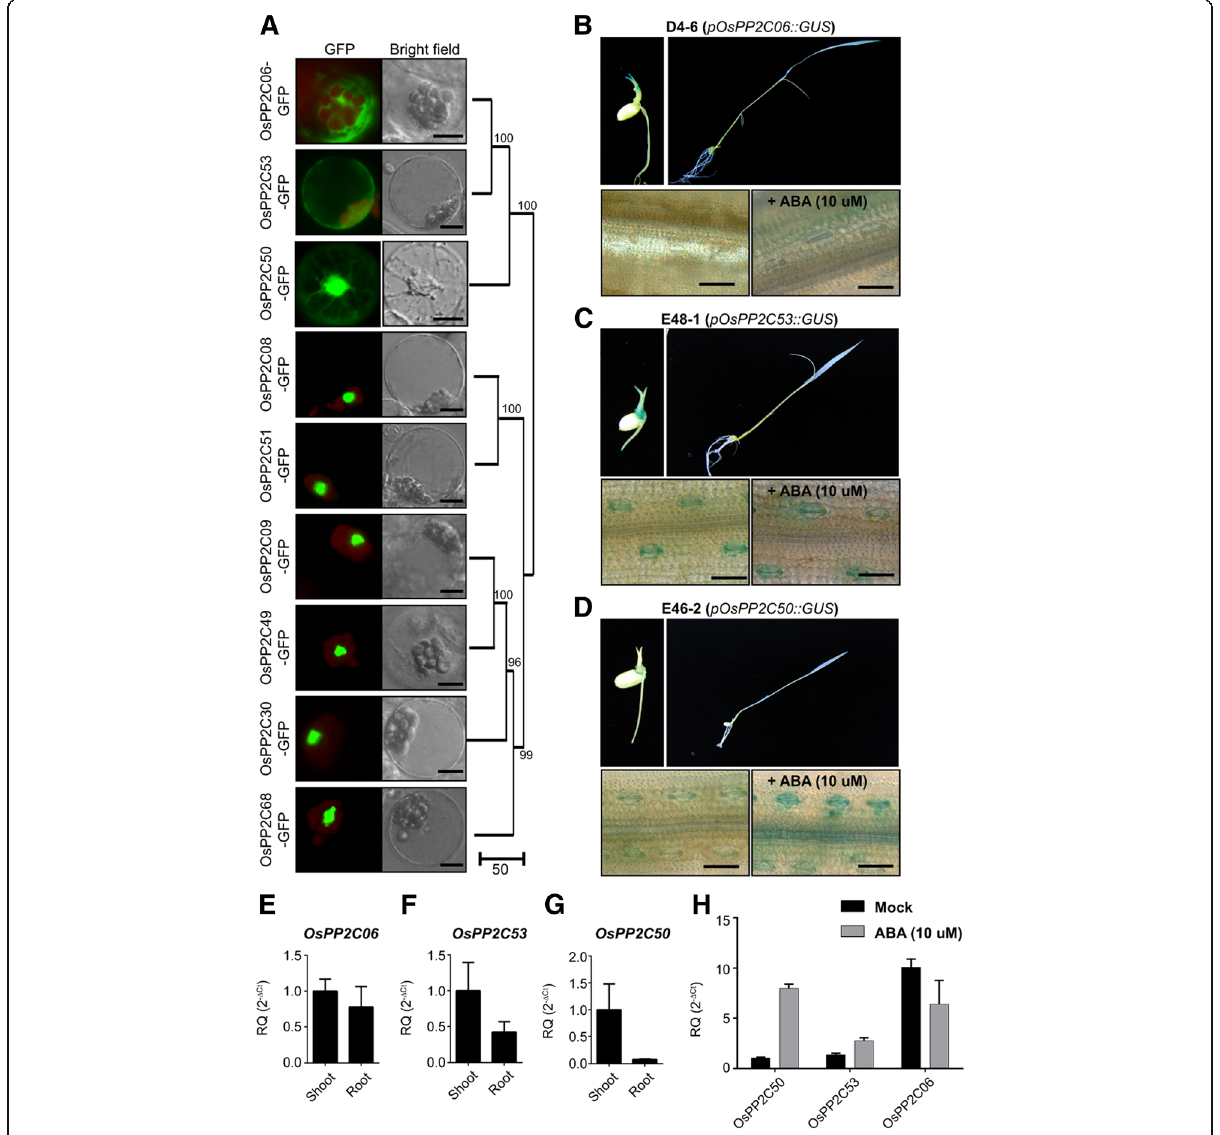
Fig. 4 Expression of OsPP2C50 and OsPP2C53 in rice guard cells and subcellular localizations of OsPP2CAs. a Subcellular localizations of nine OsPP2CAs were observed in rice protoplasts. Scale Bars=10 μ m. a Subcellular localization of OsPP2CA-GFPs in rice protoplasts. b , c , d Histochemical β -glucuronidase analysis of OsPP2CA promoter-GUS transgenic rice. Leaf surface of transgenic rice harboring OsPP2C06 promoter-GUS (D4 – 6), OsPP2C53 promoter-GUS (E48 – 1), and OsPP2C50 promoter-GUS (E46 – 2) with or without ABA treatments were stained with X-Gluc. Scale bars are 50 μ m. e , f , g RT-qPCR analysis of OsPP2C06, OsPP2C50 and OsPP2C53 using two-week-old seedlings. The generated RQ (relative quantity, 2 - Δ Ct ) was compared to the value of expression on shoot. OsUbi5 was used as endogenous control. The values depict the average and±SD with 3 replications. h RT-qPCR analysis of OsPP2C06, OsPP2C50 and OsPP2C53 using two-week-old seedlings treated or not treated with ABA. The detected RQ (relative quantity, 2 - Δ Ct ) displayed OsUbi5 was used as endogenous control. The values depict average and ± SD with 3